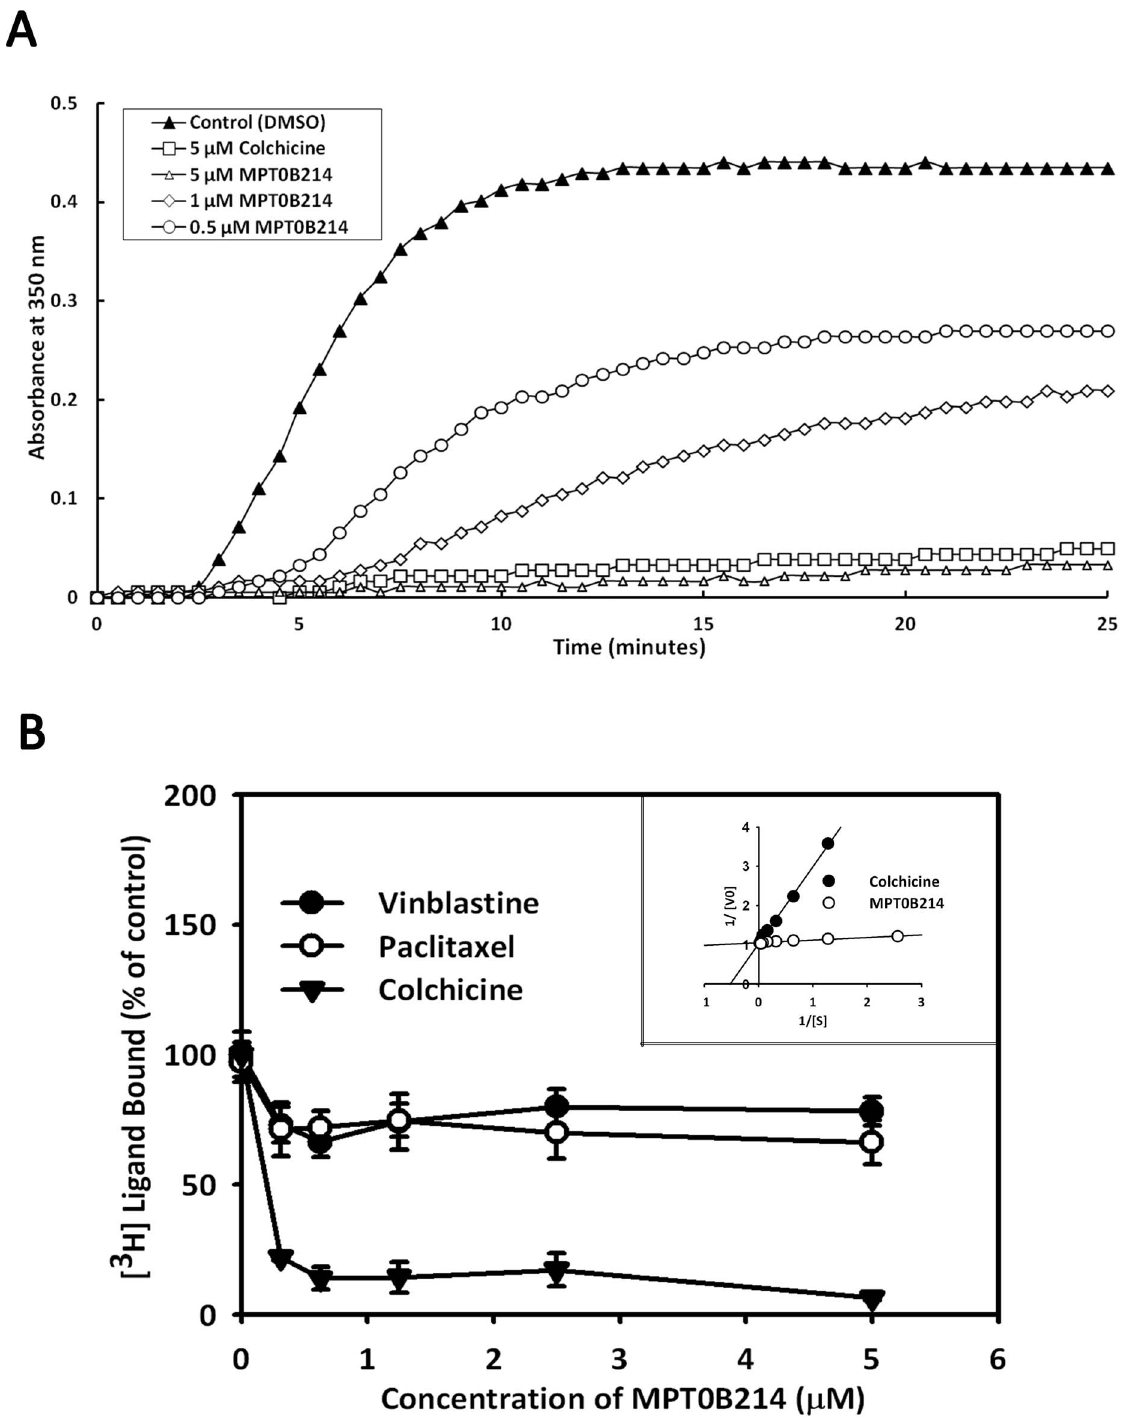
Figure 4. MPT0B214 inhibits microtubule polymerization invitro and binds to the colchicine-binding site of tubulin. (A) MPT0B214 inhibits microtubule assembly in vitro. MAP-rich tubulin was incubated at 37 u C in the absence (control, m ) or presence of colchicines (5 m M, % ) and MPT0B214 (0.5 m M, # ; 1 m M, e ; 5 m M, g ). Absorbance at 350 nM was measured every 30 s for 25 min. (B) [ 3 H] ligand bound curve. Tubulin was N incubated with the radio-labeled ligand at 37 u C, and the amount of radio-ligand bound was determined using scintillation proximity assay beads. [ 3 H] N ) competition binding curve, respectively. Each data point, the mean 6 S.D. Double-reciprocal colchicine ( . ), [ 3 H] paclitaxel ( # ), [ 3 H] vinblastine ( ), and MPT0B214 ( # ) plot showed that MPT0B214 is a competitive inhibitor of colchicine binding to tubulin, colchicine (